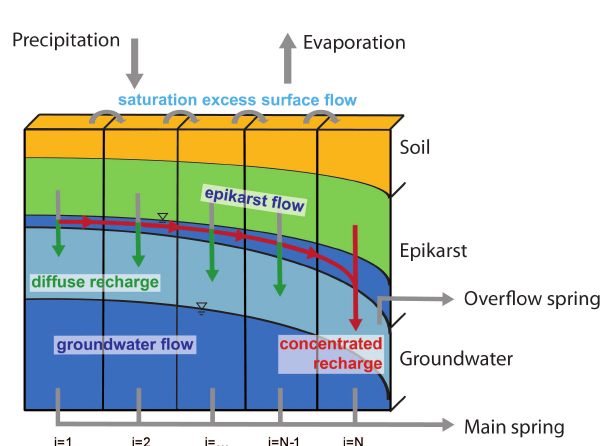
Fig. 3. Sketch of model structure adopted from Hartmann et al. (2013a) illustrating the relevant processes and connections (light blue indicates the unsaturated part of the groundwater